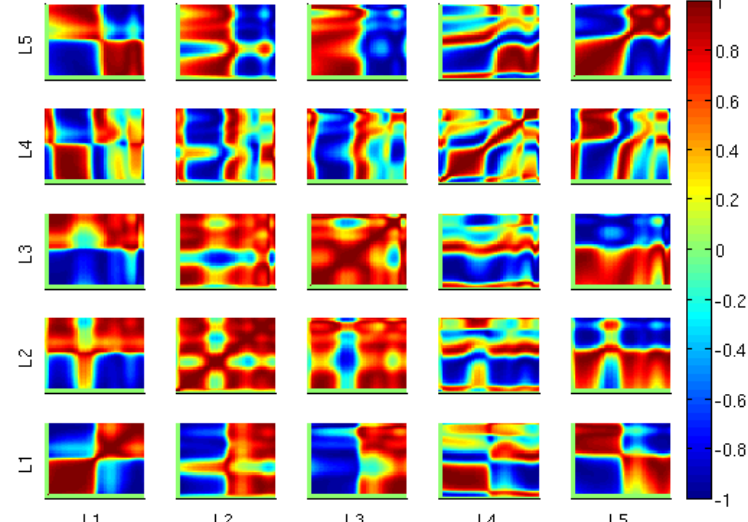
Figure 5. Correlation matrices between Legendre coefficients from the 1 st to the 5 th order for the first- level-inelastic scattering